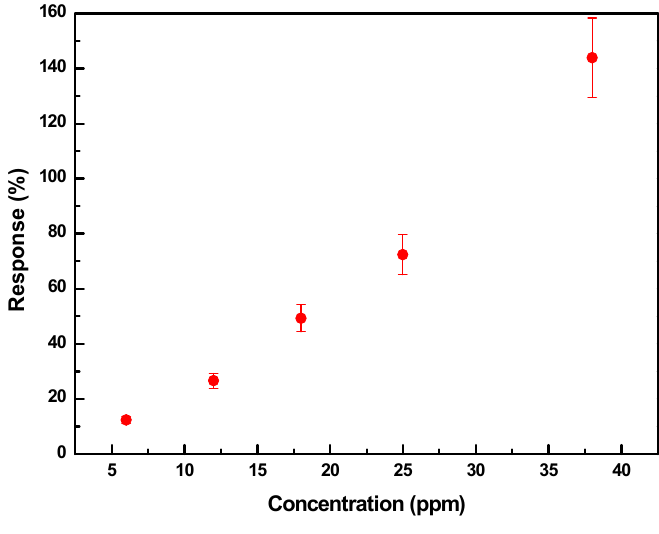
Figure 9. Response of TiO 2 sensors vs. H 2 S concentration.